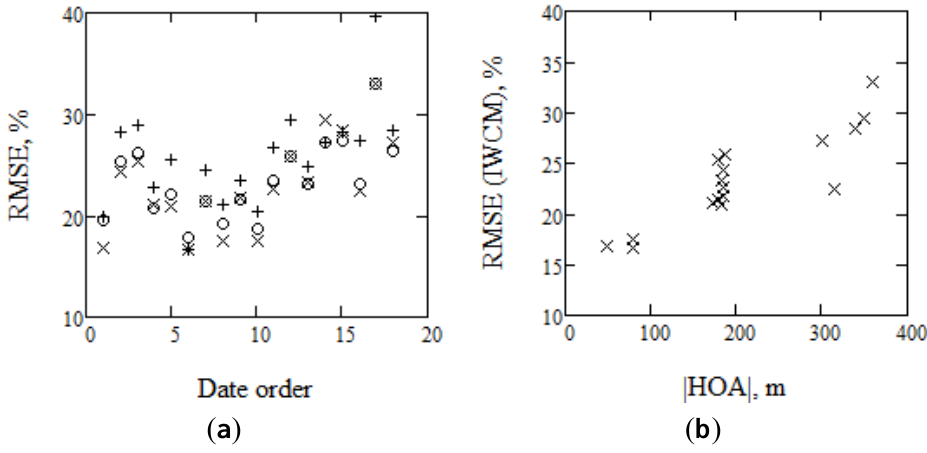
Figure 9. ( a ) Illustrating relative RMSE variation with TDM acquisition date (date order)  for IWCM, + for RVoG, o for PD. ( b ) Illustrating relative RMSE IWCM versus HOA.